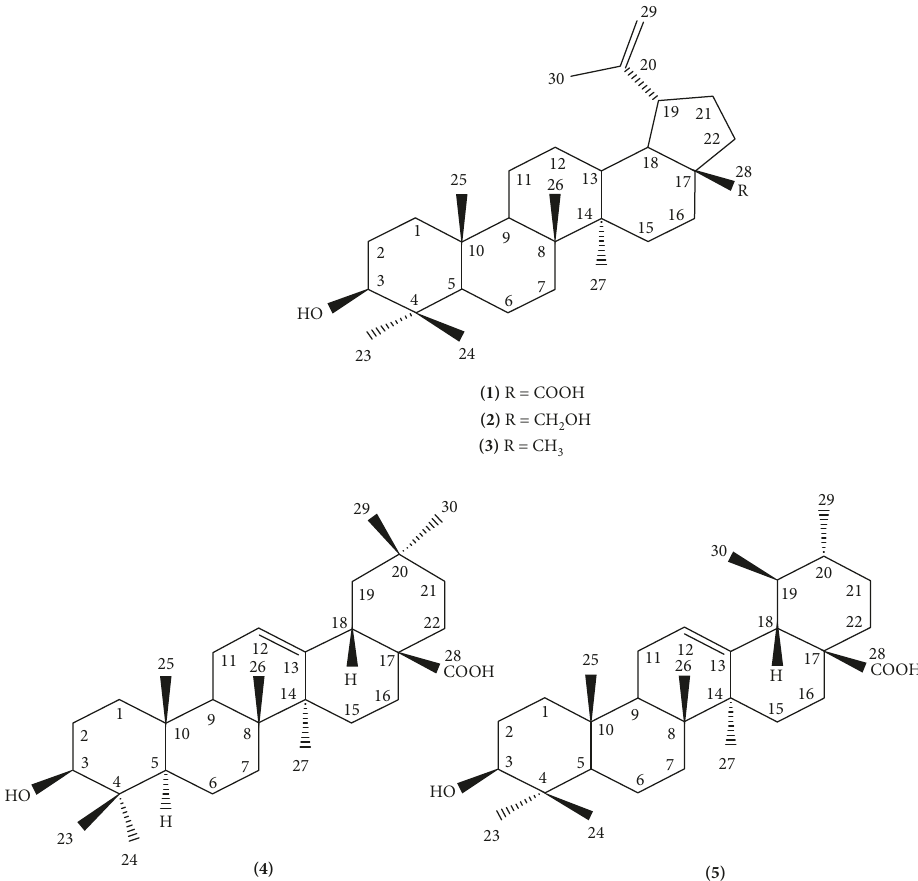
Figure 1: The structures of compounds isolated from B. alnoides ( 1 : betulinic acid; 2 : betulin; 3 : lupeol; 4 : oleanolic acid; 5 : ursolic